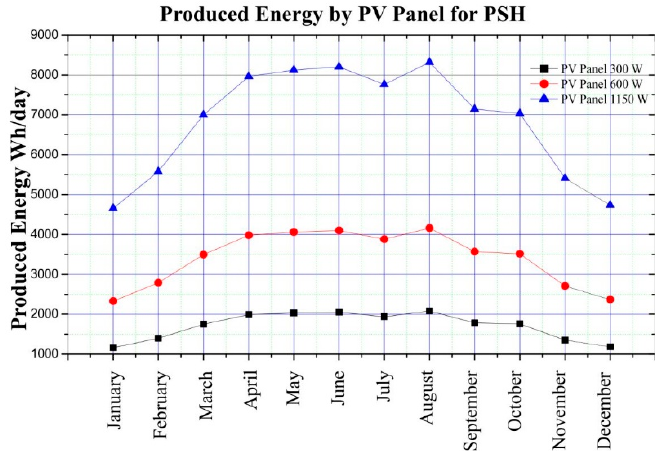
Figure 9. Produced energy by each photovoltaic panel for the peak solar hours (PSHs).